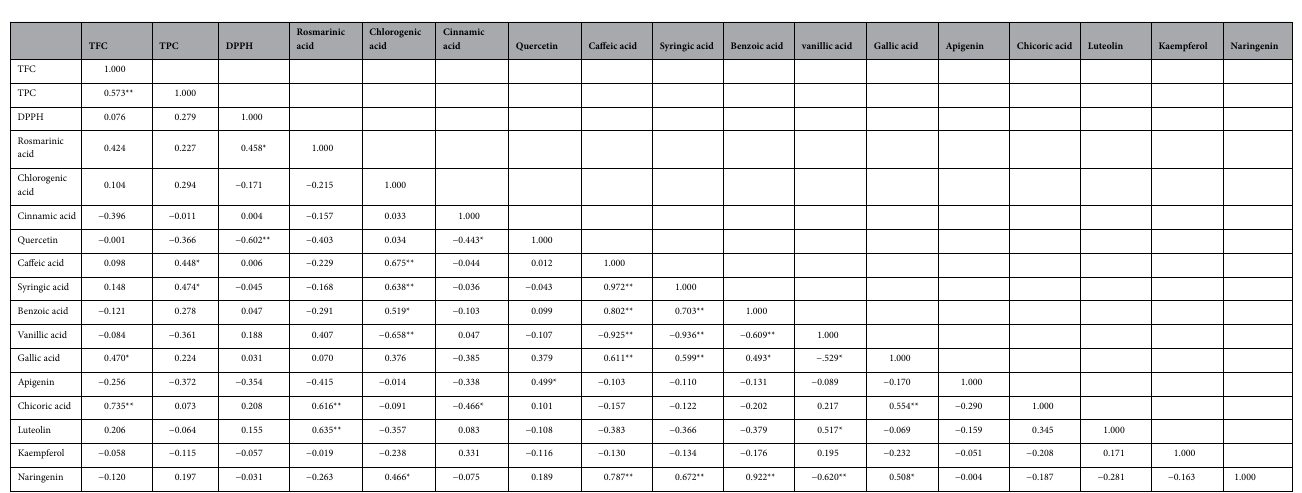
Table 3. Pearson’s correlation coefficients among antioxidants and phenolic components of oregano accessions. * and **, significant difference at 5 and 1%,